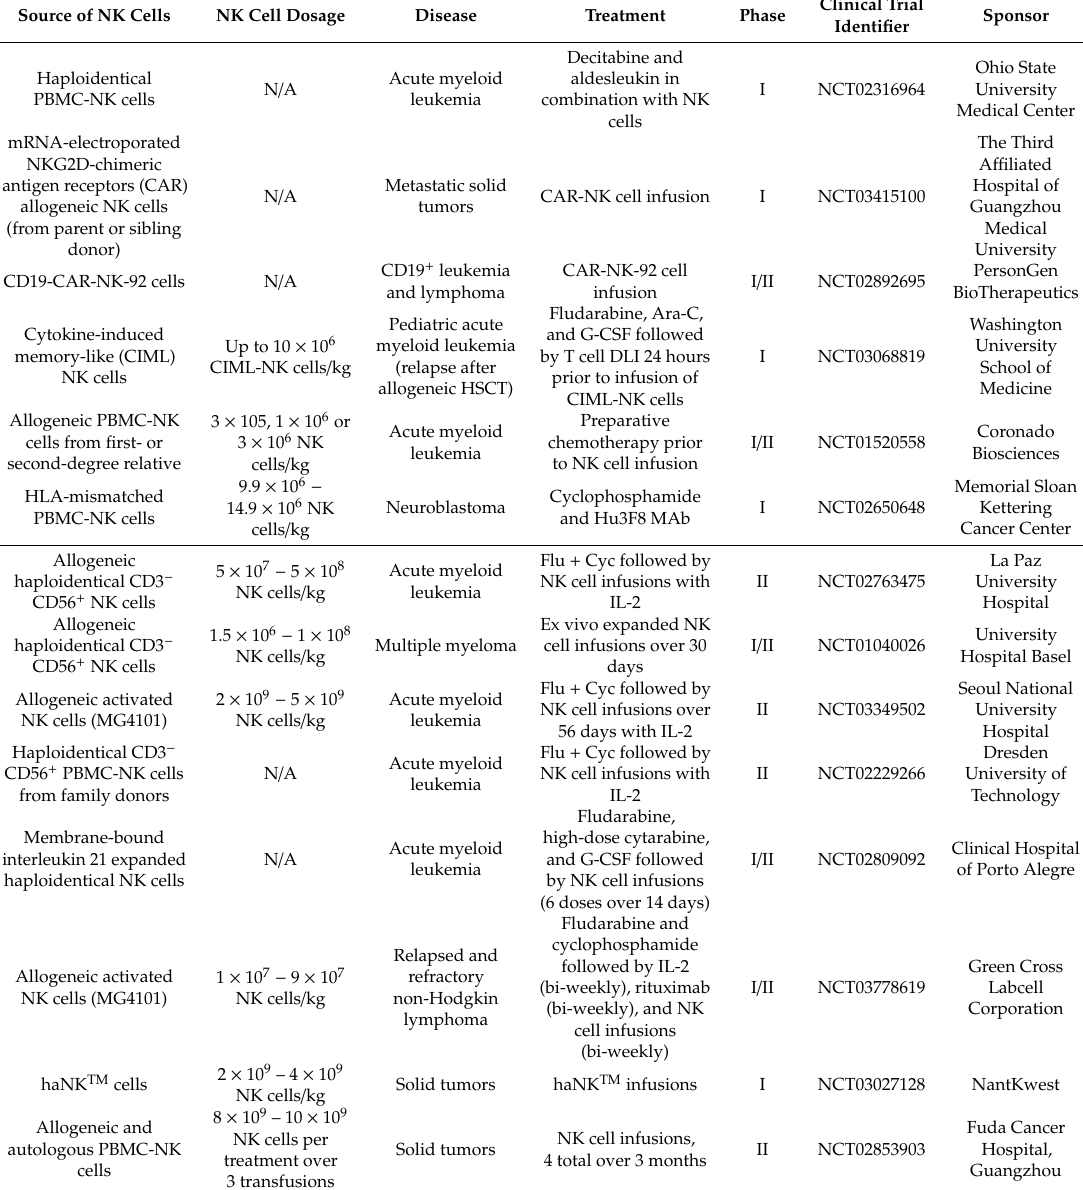
Table 2. Currently active and ongoing clinical trials with allogeneic NK cell infusions (no-HSCT). Source of NK